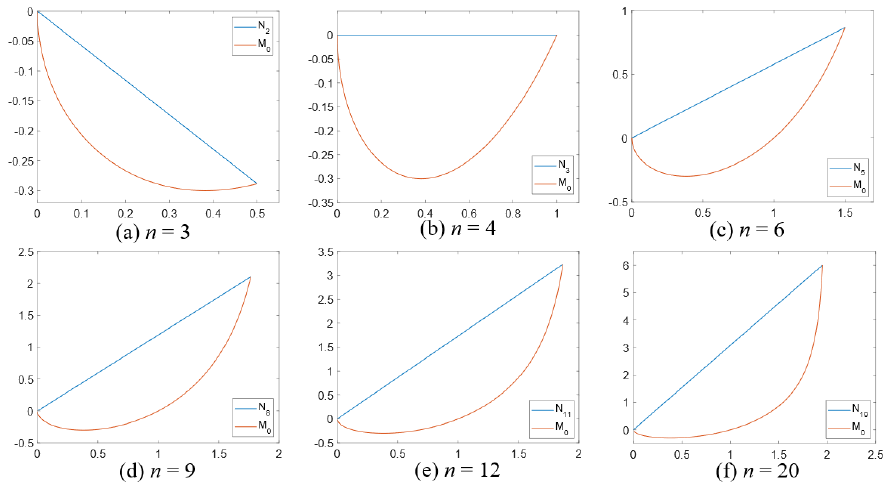
Figure 10. The trajectories of the connection’s midpoints on the x–y